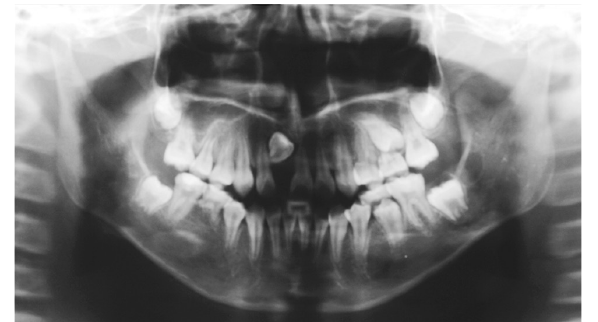
Figure 4. Pre-treatment lateral